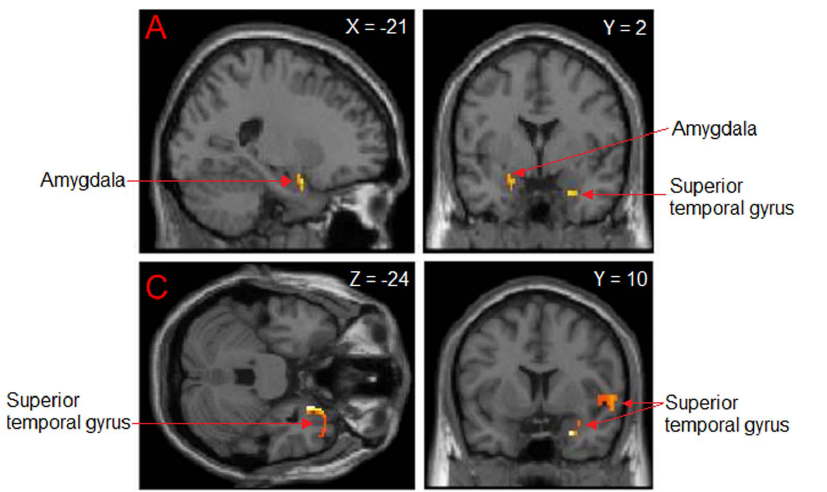
Figure 1. Regions of maternal brain activation in response to viewing own infant versus unknown infant: (A) Amygdala (SVC FWE; p , 0.05) in sagittal view, and coronal section with right superior temporal activation also visible; (B) superior temporal gyrus in horizontal and coronal view (p , 0.001 uncorrected) viewed from the right (see also Figure 2 ).